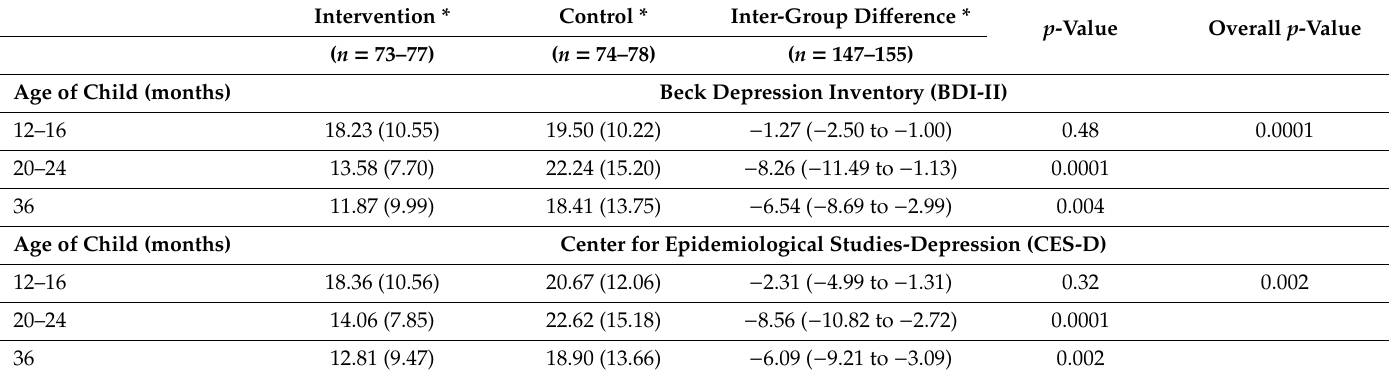
Table 2. Mean maternal depression scores derived from the BDI-II and CES-D scales.